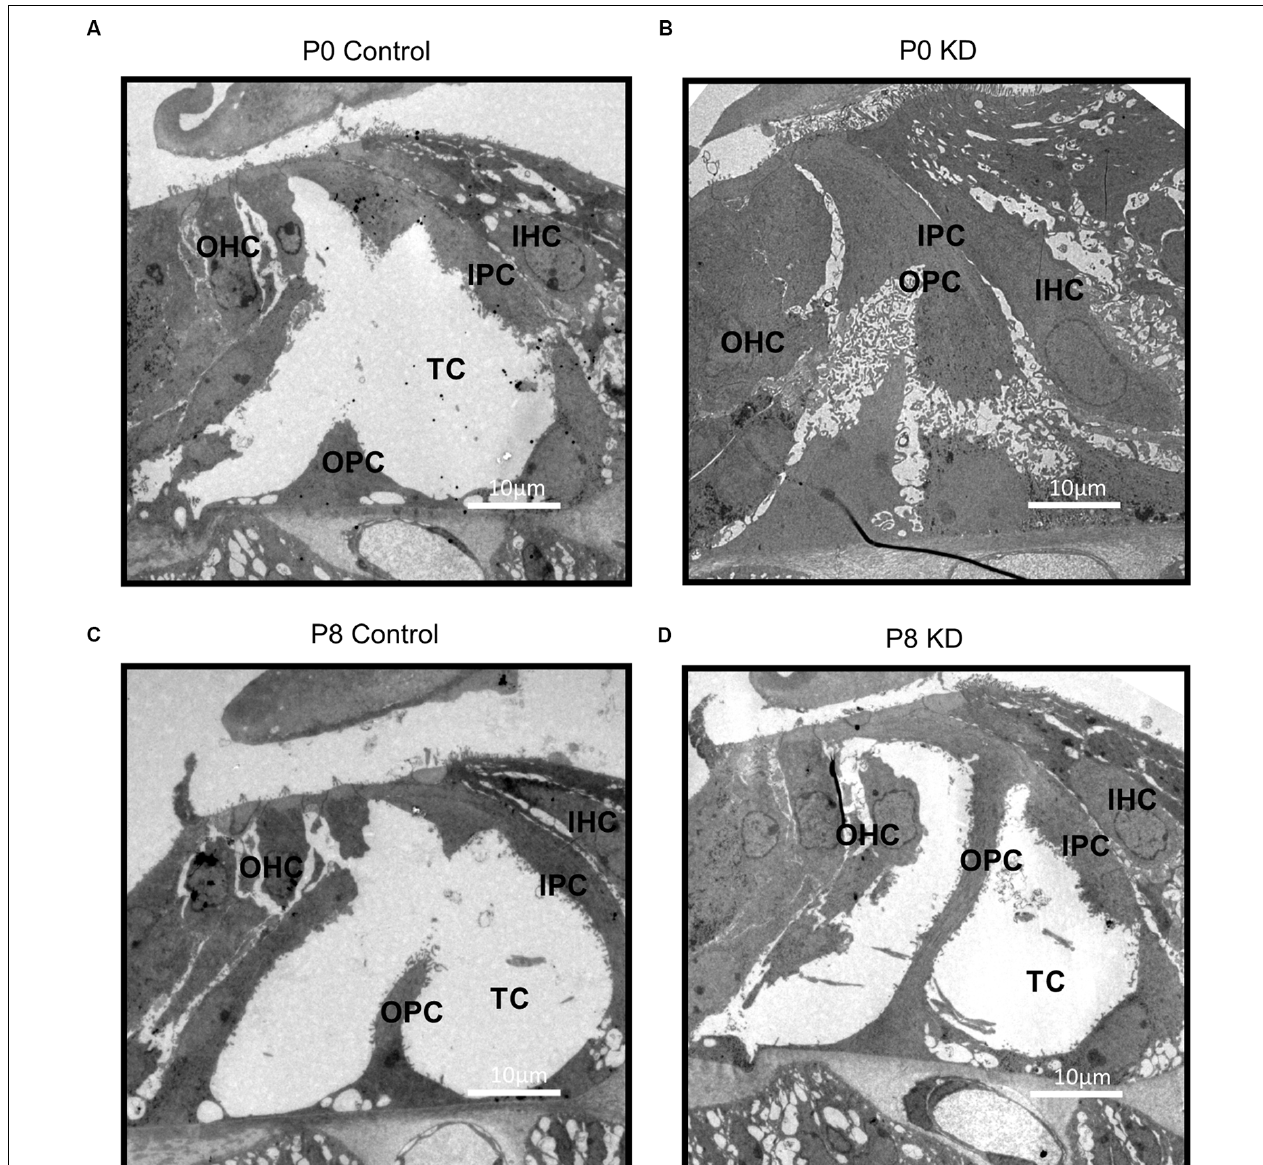
FIGURE 2 | Deformity of OC was only observed in P0 KD Group. A full view of the OC sections obtained from the P0 control (A) , P0 KD groups (B) , P8 control (C) , and P8 KD (D) . Scale bar: ∼ 10 µ m (A–D) . DC, Deiter’s cells; IHC, inner hair cells; OHC, outer hair cells; IPC, inner pillar cells; OPC, outer pillar cells; TC, tunnel of Corti; NS, Nuel’s